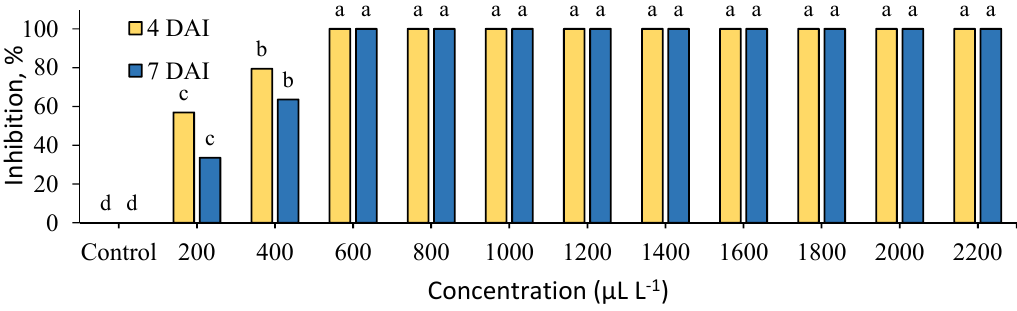
Figure 2. Inhibition (%) of Botrytis cinerea mycelial growth by clove ( S. aromaticum ) extract at 4 and 7 days after inoculation (4 DAI and 7 DAI). Results are presented as means ( n = 4). The same letter indicates no significant differences between treatments ( p < 0.05).